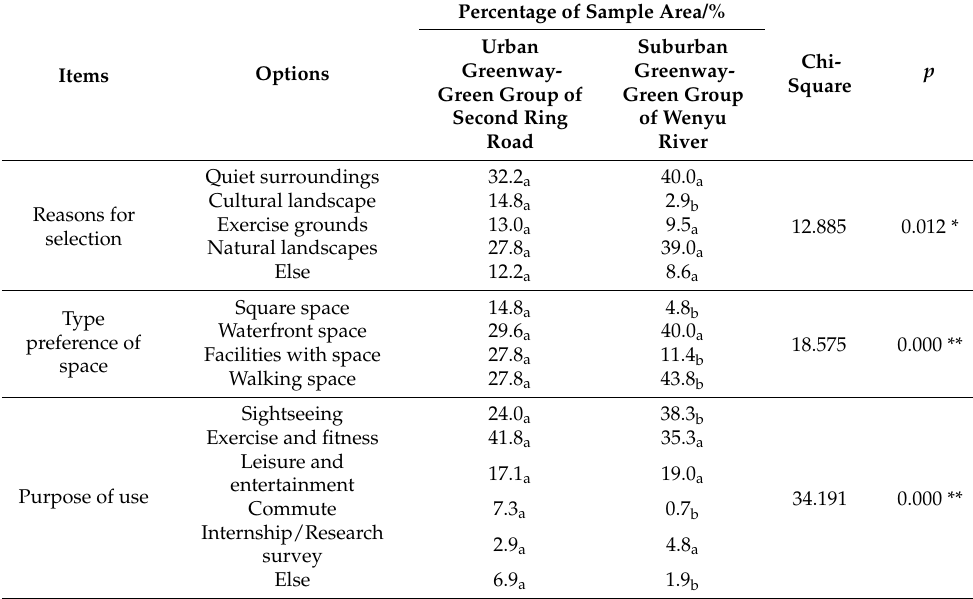
Table 5. Chi-square test for personal